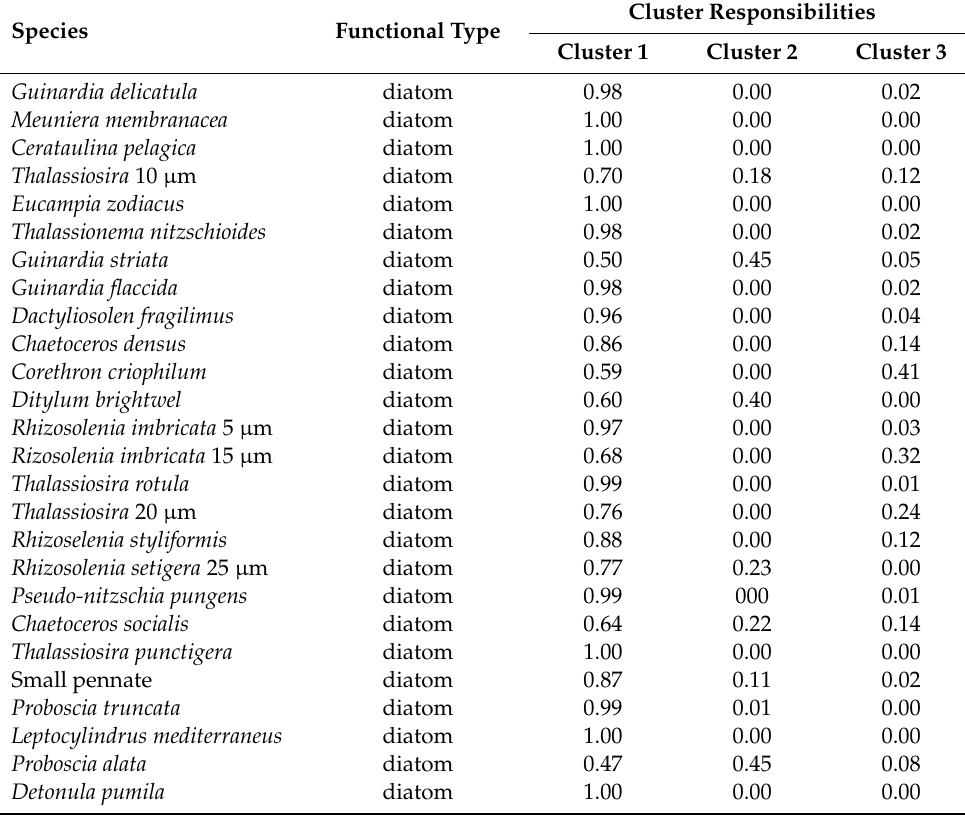
Table A1. List of species assigned to Cluster 1 by the maximum a posteriori clustering solution, their functional types, and their assignment probabilities to the three clusters. This cluster is the second largest in terms of the number of species with 26 species all of which are